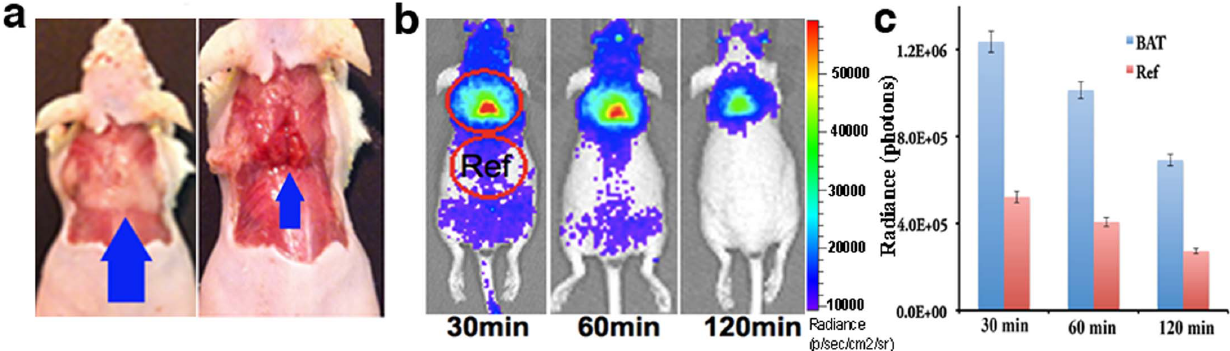
Figure 1. CLI imaging of the interscapular BAT. (a) Triangular contour of interscapular BAT (blue arrow) in a mouse; (left) BAT is covered with white adipose tissue, and (right) BAT is exposed. (b) CLI images of a mouse at 30, 60, 120 minutes after 18 F-FDG (10.3 MBq) intravenous injection. The images clearly outline the contour of BAT, even after 120 minutes of 18 F-FDG injection. (c) Quantitative analysis of CLI signal from interscapular BAT area and a reference area.